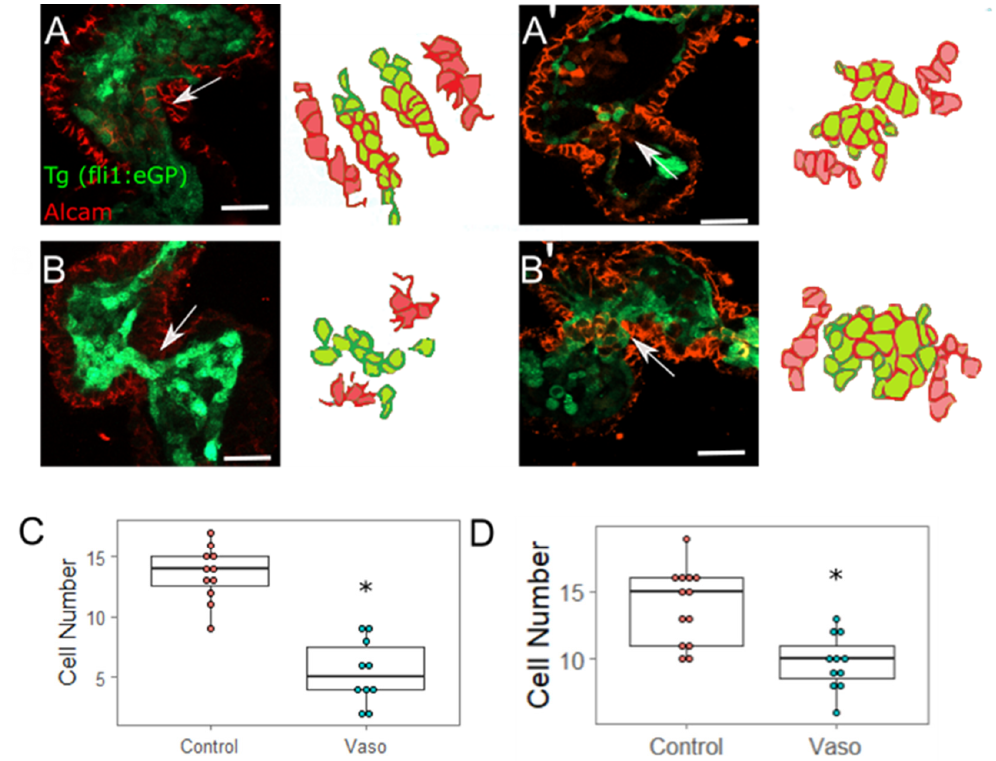
Figure 6. Increased myocardial afterload causes aberrant AVJ cell specification. ( A ) Control hearts stained with ALCAM at 56 hpf. ( A ’) Control hearts stained with ALCAM at 72 hpf. Scale bar represents 20 µ m. ( B , B ’) Representative image of vaso-treated heart at ( B ) 56 hpf and at ( B ’) 72 hpf. ( C ) Number of ALCAM expressing endocardial cells. N = 11 wildtype hearts, 10 vaso treated hearts at 56 hpf. Statistical significance was determined using Student’s t -test; * indicates p < 0.05. ( C , D ) Number of ALCAM expressing endocardial cells. N = 11 wildtype hearts, 10 vaso-treated hearts at 72 hpf. Five cells were analyzed per location per heart, area was measured for each cell and averaged. AVJ myocardial cells were defined as myocardial cells located in the constriction between the atrium and ventricle.